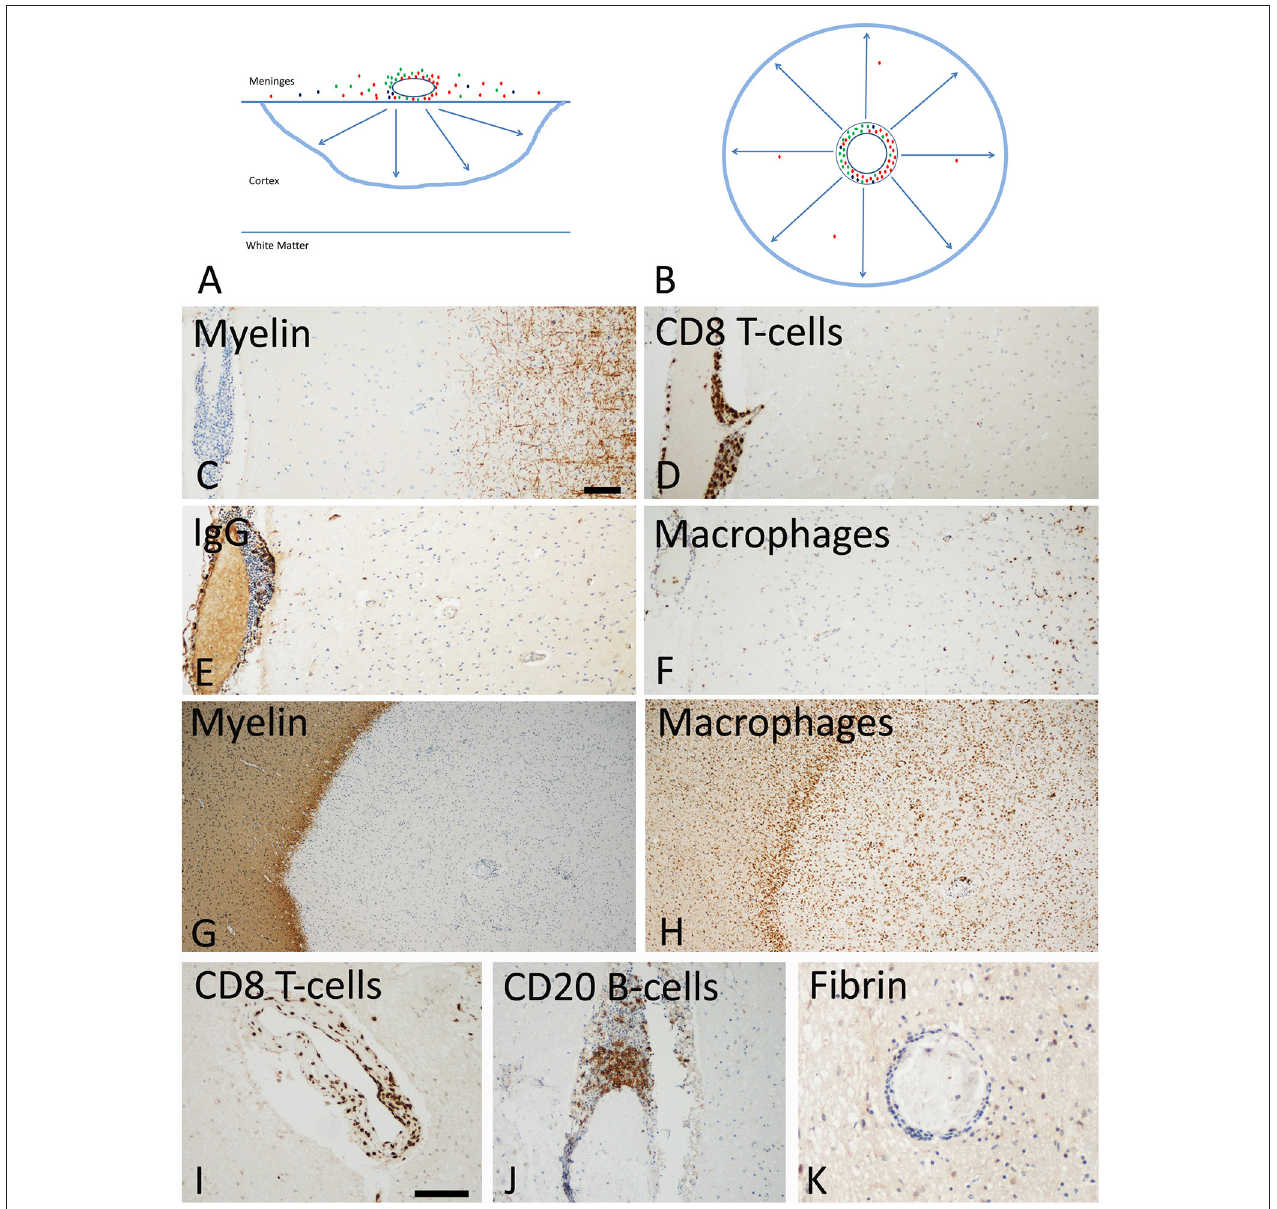
FIGURE 3 | Slowly expanding lesions in the progressive stage of MS in the cortex and the white matter. (A) Active cortical lesions are associated with inflammatory infiltrates in the meninges, which are composed of CD8 + T-cells (red), CD20 + B-cells (green) and plasma cells (blue). Active demyelination occurs at a distance of the inflammatory infiltrates and is associated with activated microglia (blue lesion rim). The lesions gradually expand from the pial surface of the cortex toward the depth of the gray matter. Lymphocyte infiltrates are rare or completely absent in the cortical tissue and in particular at the zone of active demyelination. It is suggested that the inflammatory infiltrates in the meninges produce a soluble factor, which induces demyelination and neurodegeneration either directly or indirectly through microglia activation (arrows). (B) In slowly expanding lesions in the white matter T-cell, B-cell and plasma cell infiltrates are present in the large perivascular Virchow Robin spaces. Active demyelination and neurodegeneration occurs at a distance and is associated with microglia activation. Also in these lesions it is suggested that demyelination and neurodegeneration is driven by a soluble factor, produced by the perivascular lymphocytes or plasma cells (arrows). (C–F) Active cortical lesion in a patient with progressive MS. Subpial myelin is completely lost in an area with meningeal inflammation (C) ; CD8 + T-cells are present in the meningeal infiltrates, but do not enter the cortical parenchyme (D) ; The meningeal infiltrates also contain IgG positive plasma cells (E) , there is however no indication of IgG leakage from the vessels into the tissue, suggesting an intact blood brain barrier. Activated microglia and macrophages are seen at the site of active demyelination in the depth of the gray matter (F) . (G,H) Slowly expanding lesion in the white matter of a patient with progressive MS. The inactive plaque center contains vessels with perivascular cuffs of lymphocytes but the active demyelination at the lesion edge is associated with a rim of activated microglia (G,H) . Lymphocytes, such as for instance CD8 + T-cells and B-cells are present in the large perivascular space of the vessels, but there is little or no infiltration into the lesion parenchyme (I,J) . No fibrinogen leakage is observed around inflamed vessels, indicating intact blood brain barrier function (K) . Magnification bar representative for all images: 100 µ m. Similar histological images as shown in this figure have been previously published. Structure of the lesions: Frischer et al. (46); Inflammatory reaction: Frischer et al. (47); Machado Santos et al. (37); Microglia and macrophages: Zrzavy et al. (38); Fibrin and blood brain barrier injury: Hochmeister et al. (48).